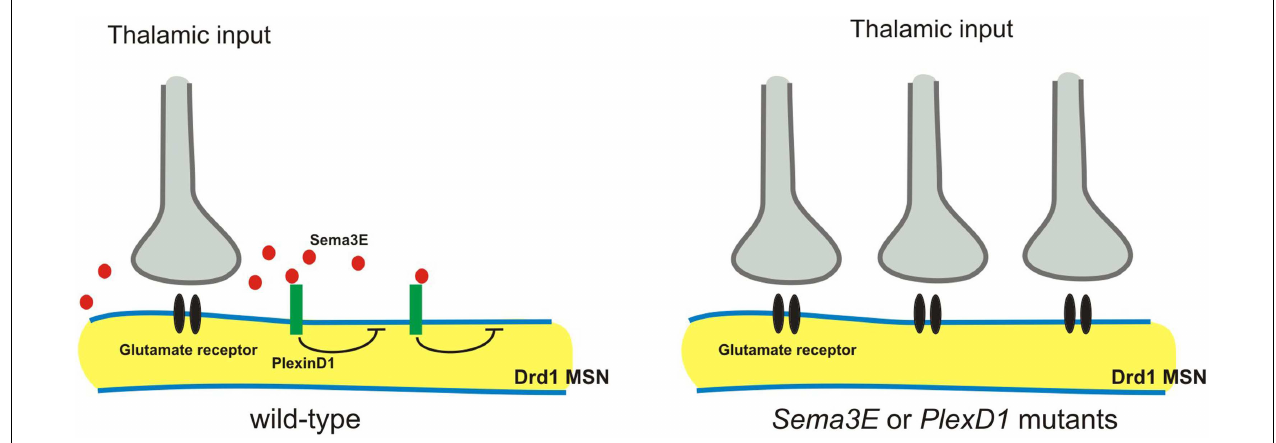
MSNs in the striatum, whereas Sema3E is expressed by subsets of neurons in the main thalamic nuclei that project to the striatum. Loss of Sema3E-PlexD1 signaling causes functional and anatomical rearrangement of thalamostriatal synapses specifically in direct pathway MSNs without effects on corticostriatal